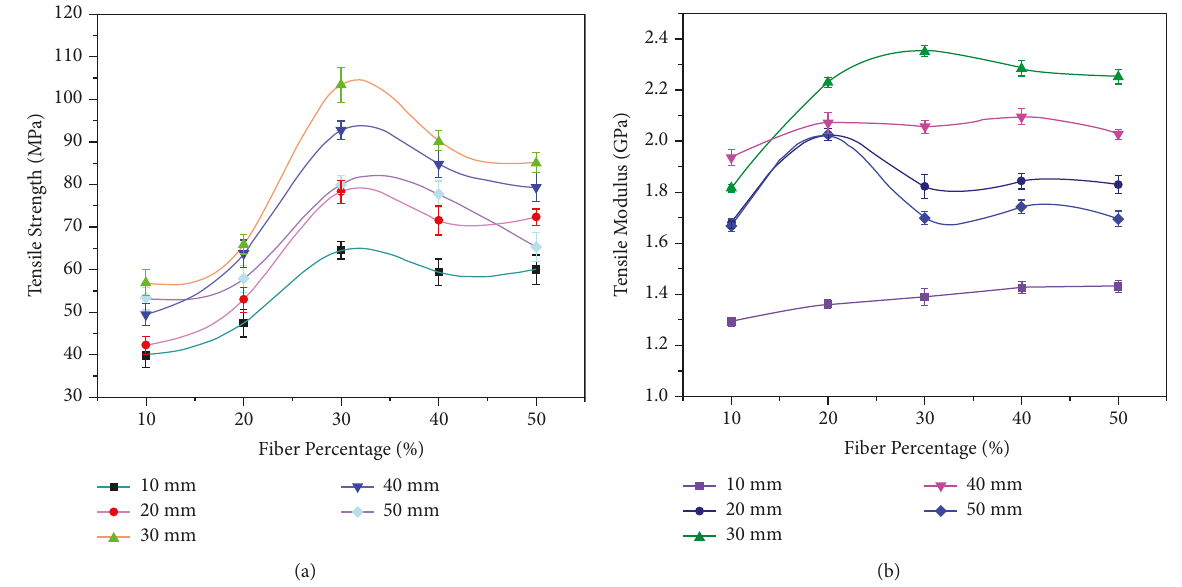
Figure 2: Effect of fiber length and weight percentage on (a) tensile strength and (b) tensile